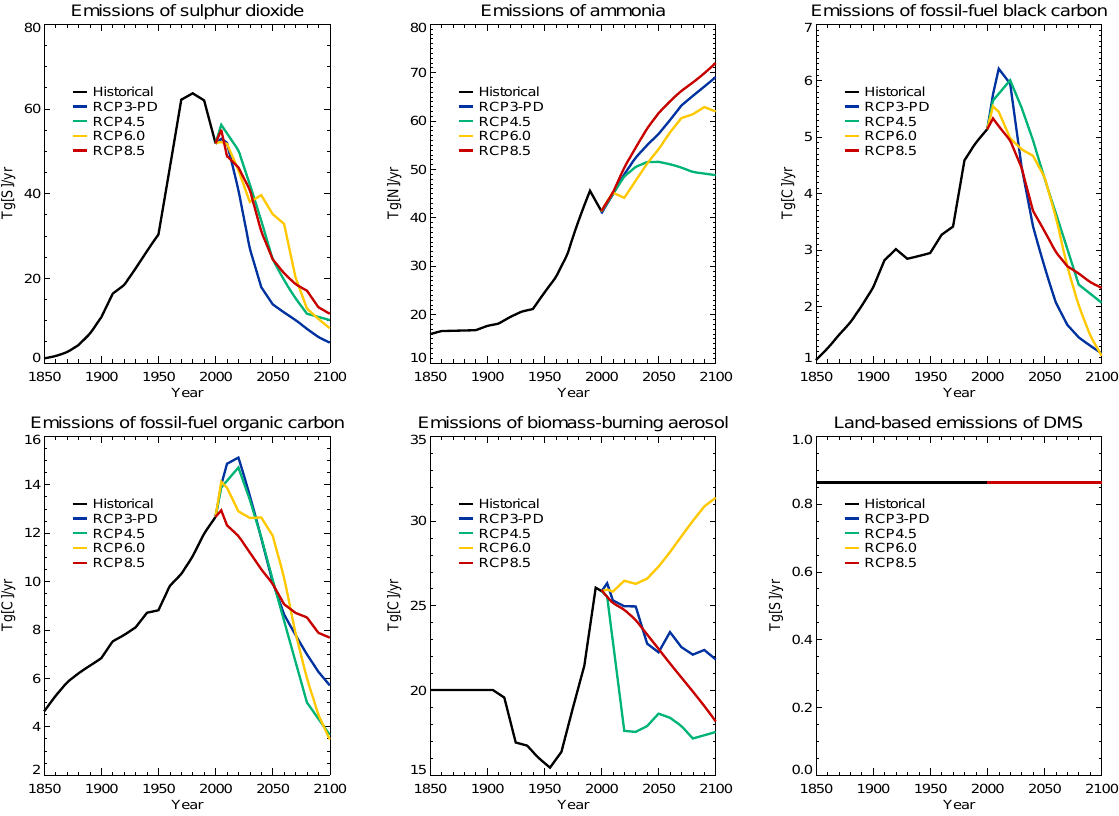
Fig. 10. Tropospheric aerosol precursors and aerosol primary emissions over the historical period (1860–2005), and future period (2005– 2100) for 4 RCPs: RCP3-PD (blue), RCP4.5 (green), RCP6.0 (yellow), RCP8.5 (red).